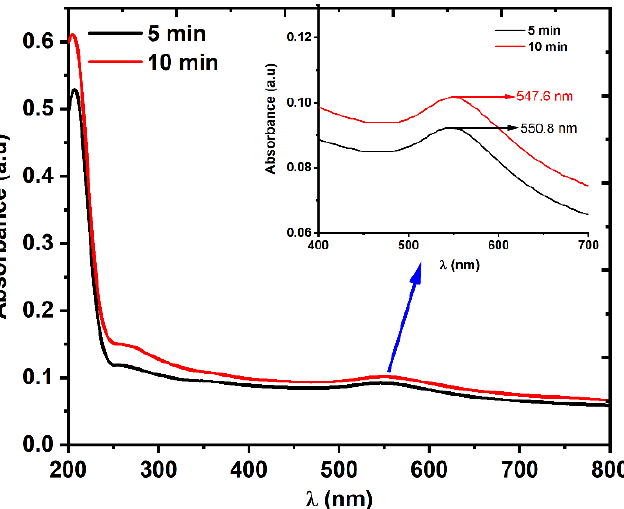
Figure 5. The linear absorption spectra of two Au NP samples that were prepared using 5 and 10 Figure 4. The size distribution of Au NPs that were prepared using a 10 min laser ablation